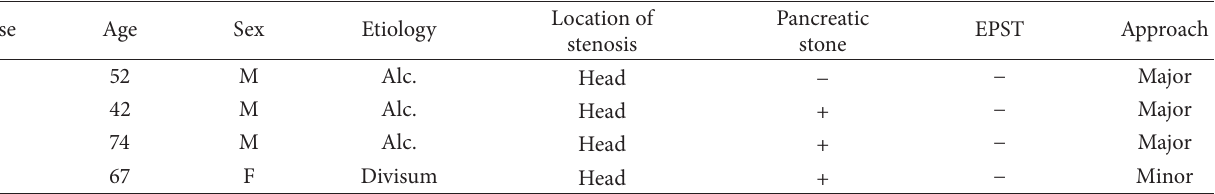
Table 8: Patients characteristics of fractured cases.